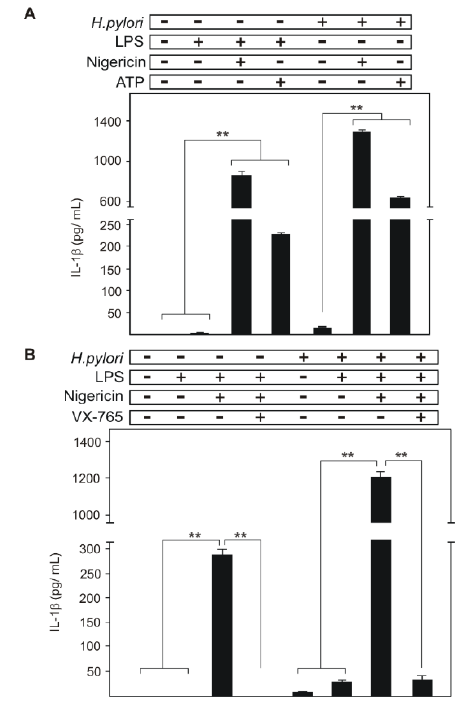
Figure 2. NLRP3 inflammasome activation in THP1 monocytes was compared with H. pylori infection at 6 h of treatment. E. coli LPS / Nigericin and LPS / ATP were used as signal-1 / signal-2 for canonical activation of the NLRP3 inflammasome in THP1 monocytes as described in the text ( A ). H. pylori infection secreted low amounts of IL-1 β when compared with canonical NLRP3 inflammasome activation-mediated mature IL-1 β secretion. Moreover, E. coli LPS / H. pylori co-treatment showed a corresponding increase in IL-1 β secretion but this was not comparable with the inflammasome activation response ( B ). However, H. pylori -infected cells treated with signal-2 activators Nigericin or ATP induced the production of a high amount of mature IL-1 β secretion ( A , B ). The caspase-1 inhibitor VX-765 inhibited all NLRP3 inflammasome driven IL-1 β secretion in LPS treated or H. pylori -infected cells after activation but infected cells maintained basic secretion ( B ). ** p ≤ 0.01